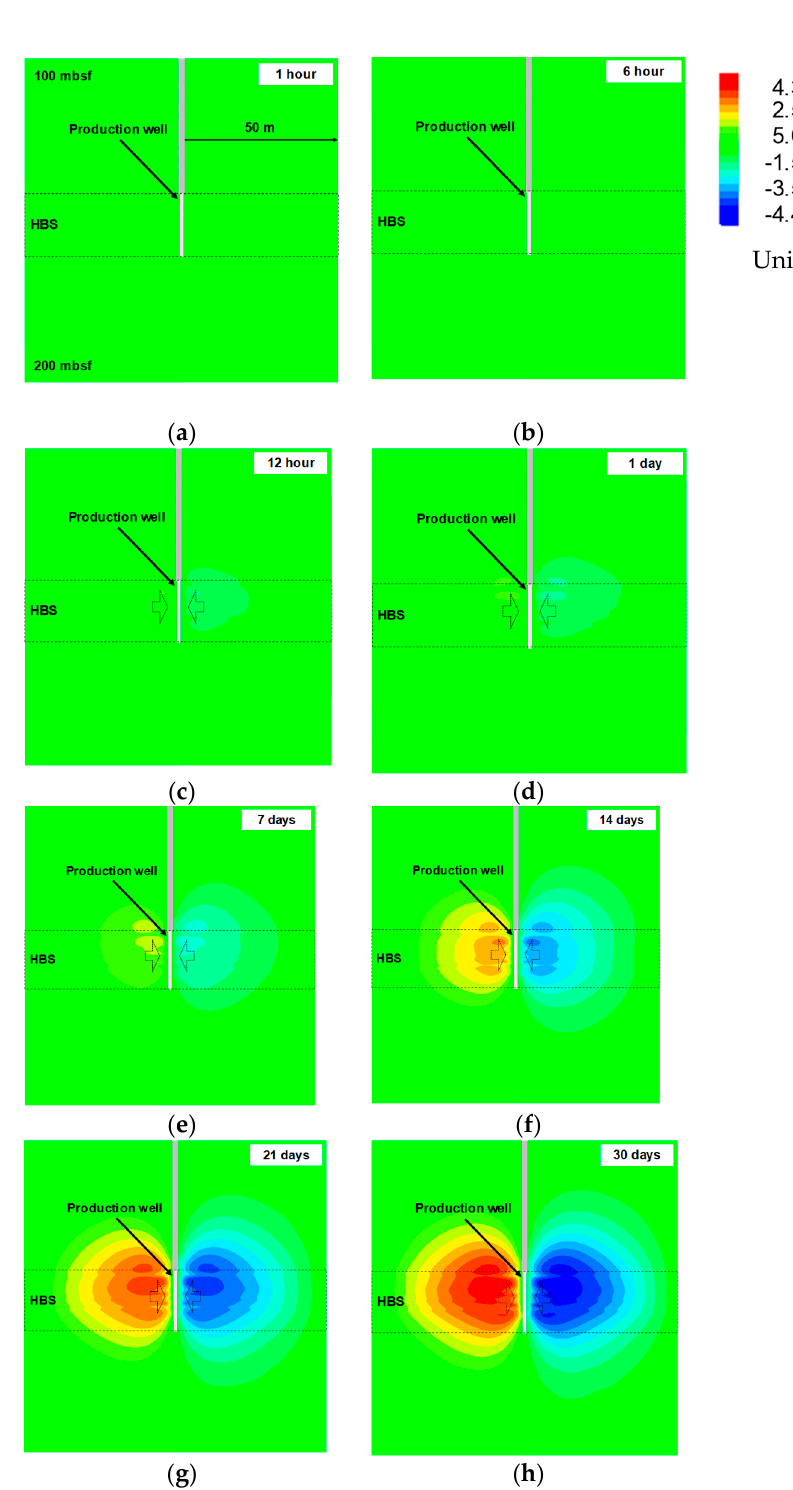
Figure 9. Distribution of x-axis displacement with production period: ( a ) after 1 hour; ( b ) after 6 hours; ( c ) after 12 hours; ( d ) after 1 day; ( e ) after 7 days; ( f ) after 14 days; ( g ) after 21 days; ( h ) after 30 days.